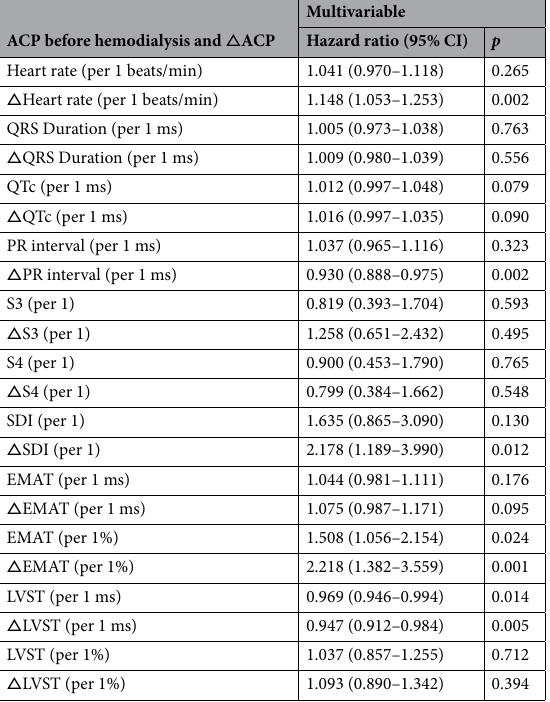
Table 3. Relation of acoustic cardiography parameters before hemodialysis and △ acoustic cardiography parameters to overall mortality. Values expressed as hazard ratio and 95% confidence interval (CI). Abbreviations are the same as in Table 1. Covariates in the multivariable model included age, sex, diabetes mellitus, hypertension, coronary artery disease, arteriovenous access type, dialysis vintage, systolic and diastolic blood pressures, albumin, log triglyceride, total cholesterol, hemoglobin, total calcium, phosphorous, CaXP product, potassium, uric acid, Kt/V, blood flow, and medications including ACEIs and/or ARBs, β-blocker, statin and aspirin.